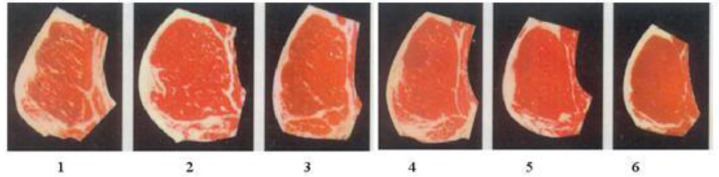
Grade map of marbling.